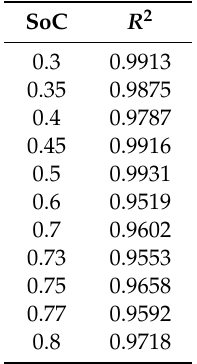
Table 2. R 2 of 11 fitting curves ( dV = 0.02 V).